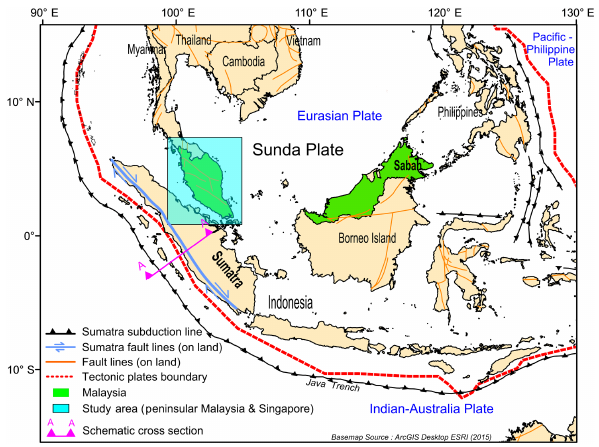
Figure 1. Location of Peninsular Malaysia on the Sunda Plate and the seismic sources around it (modified from Loi et al., 2016). The subduction lines, fault lines and tectonic boundary were obtained from ArcGIS